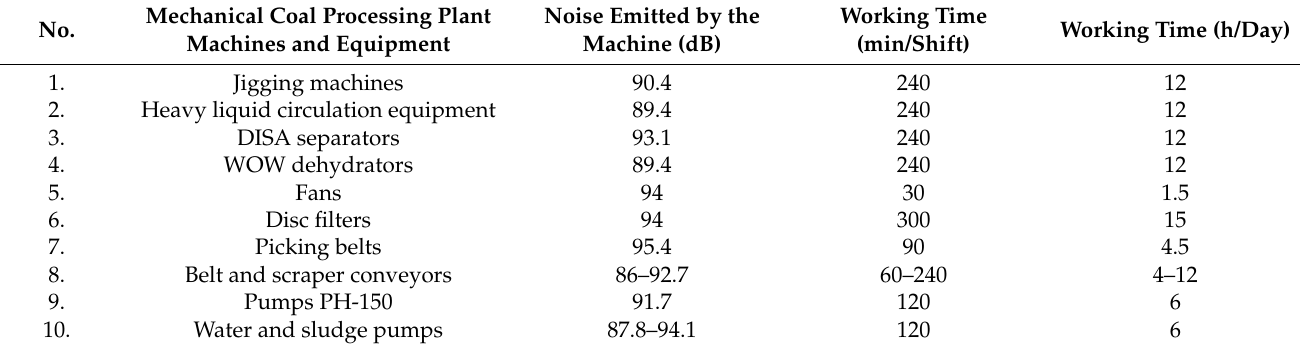
Table 3. List of devices in the mechanical coal processing plant emitting noise above NDN.